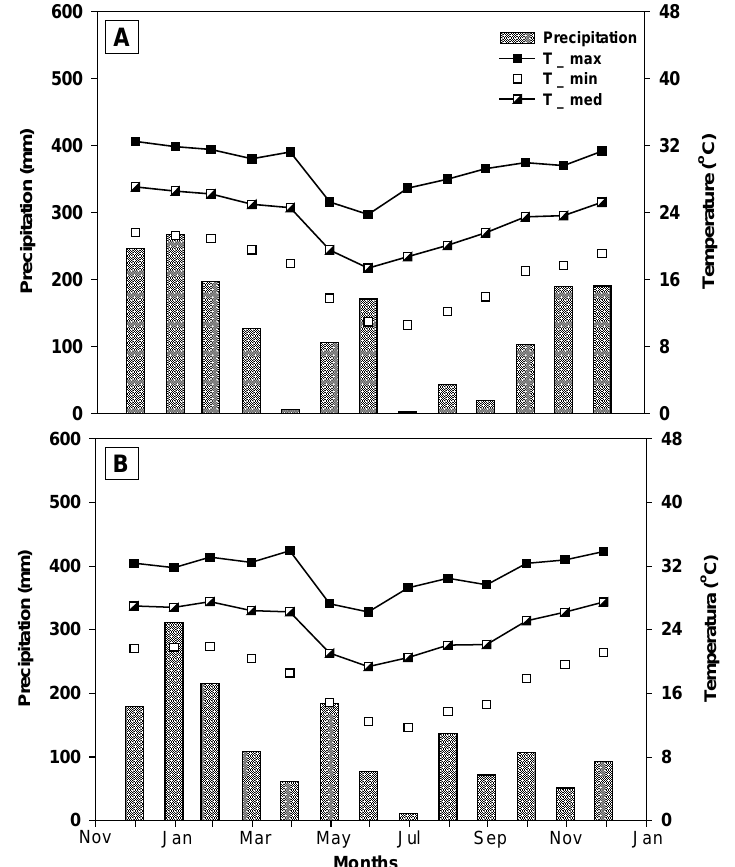
Figure 2. Mean monthly temperatures (maximum, mean, and minimum) (°C) and monthly precipitation (mm) in Area 1 (Capivari, SP) ( A ) and Area 2 (Valparaiso, SP) ( B ) from 1 December 2015 to 31 December 2016. Sources: CEPAGRI [29] and ESALQ [30].